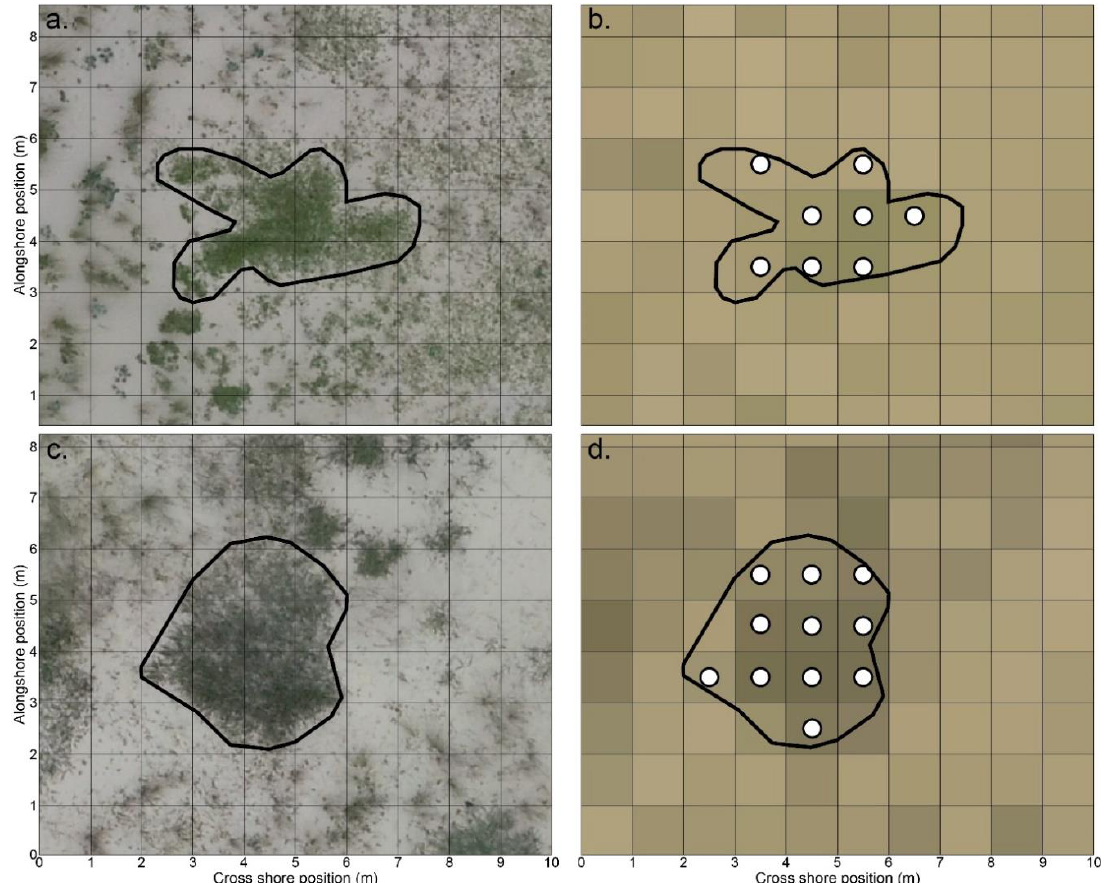
Figure 2. Zoom in on a Galium arenarium patch using ( a ) a 0.02 m resolution unmanned aerial vehicle (UAV) orthomosaic and ( b ) a 1 m resolution airbornepseudo-color VNIR image. Zoom in on an Artemisia campestris patch using ( c ) an UAV orthomosaic and ( d ) an airborne image. The black lines represent the contour of the vegetation patch, and the white dots the pixels are used as control points.